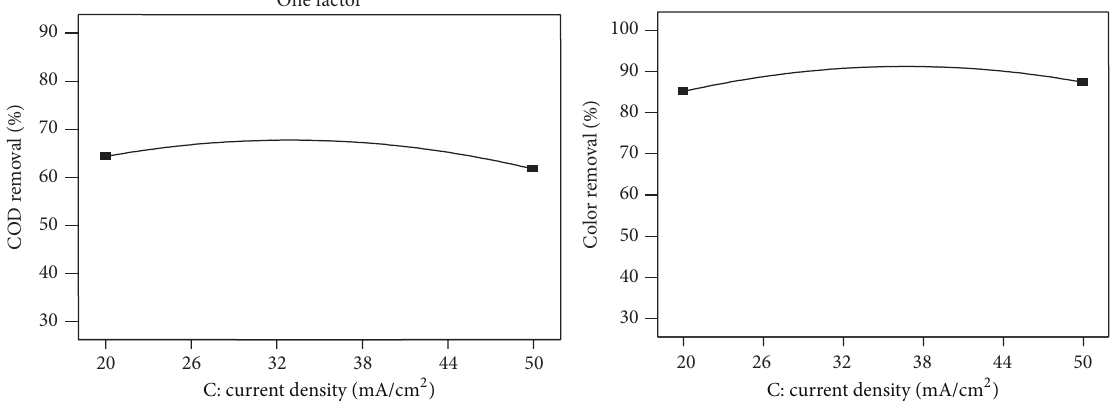
Figure 4: Effect of current density on COD and color